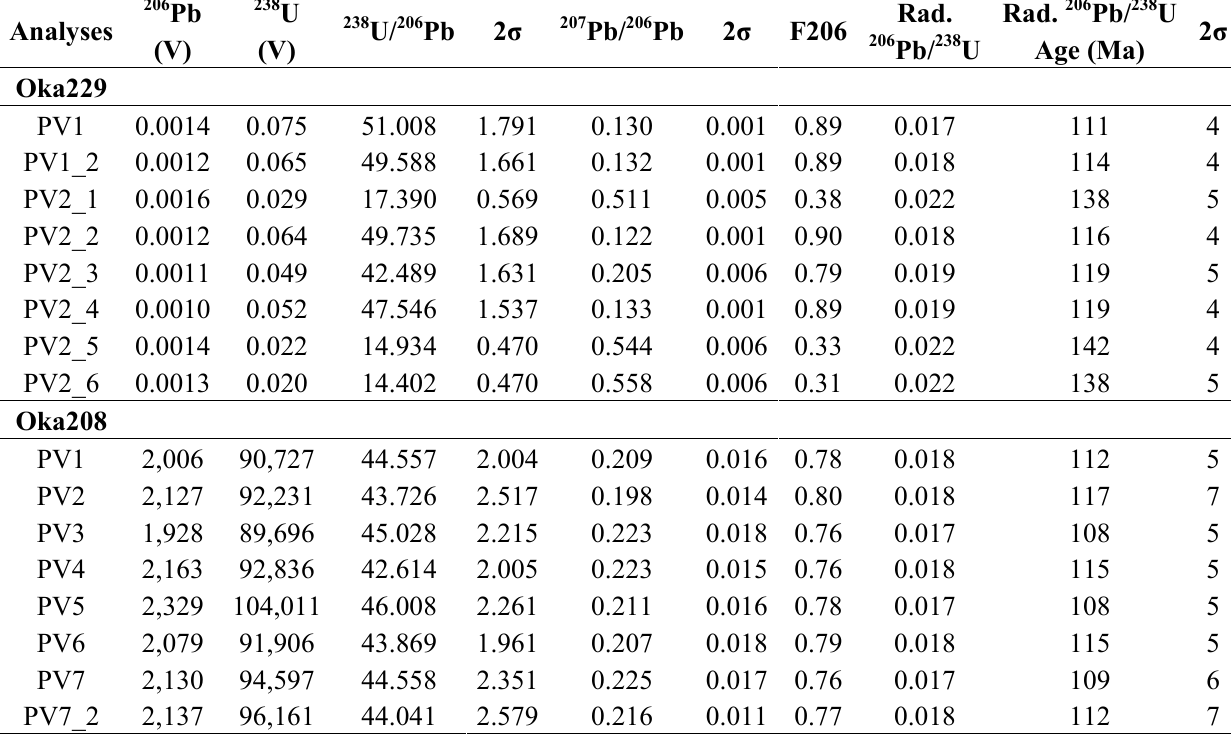
Table 7. In-situ U-Pb geochronological results for perovskite by LA-(MC)-ICP-MS.